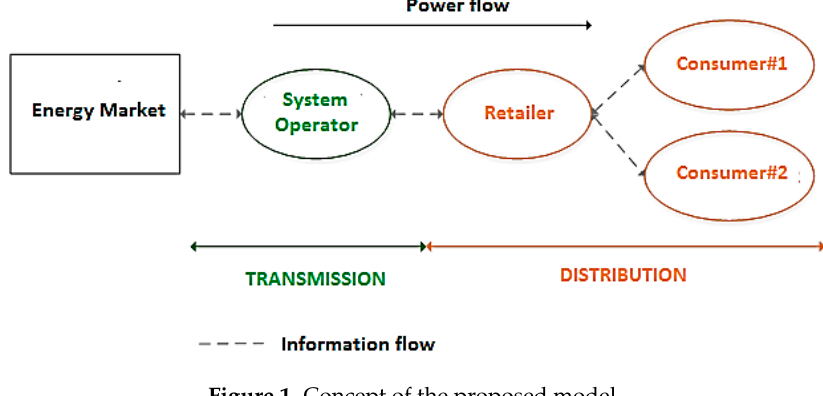
Figure 1. Concept of the proposed model.